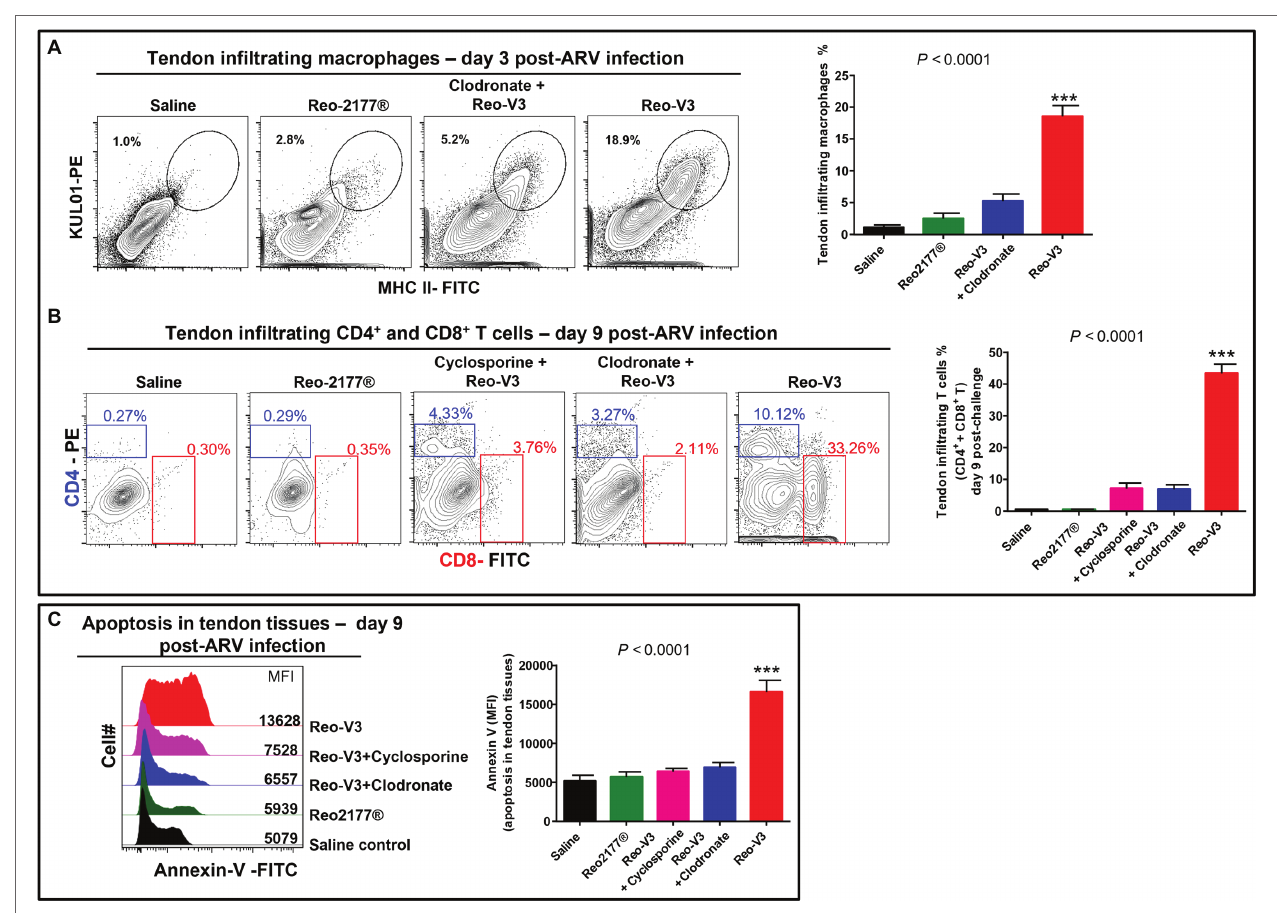
FIGURE 10 | Flow cytometry analysis of the effect of depletion of antigen presenting cells or inhibition of T-cell proliferation in birds in the tendon tissue cell apoptosis post-Reo-V3 (genotype cluster-2) infection. (A) Proportion of tendon infiltering macrophages in saline (control), non-pathogenic vaccine strain (Reo- 2,177®), Clodronate liposome + Reo-V3 (i.e., clodronate liposome administration followed by infection with Reo-V3), and Reo-V3 alone groups at day 3 post- infection. Bar graph: mean percentages (±SD) of tendon infiltrating macrophages based on three independent experiments. (B) Percentage of tendon infiltrating CD4+ and CD8+ T lymphocytes in the indicated groups at day 9 post-infection. Bar graph: mean percentages (± SD) of tendon infiltrating combined CD4+ and CD8+ T lymphocytes in the indicated groups based on three independent experiments ± SD. (C) Apoptosis of tendon tissue cells of birds in the indicated groups at day 9 post-Reo-V3 infection determined by Annexin-V fluorescein staining. Graph: MFI of apoptotic tendon tissue cells in the indicated groups based on three independent experiments. Asterisks indicate group that was significantly different from other groups, *** p <